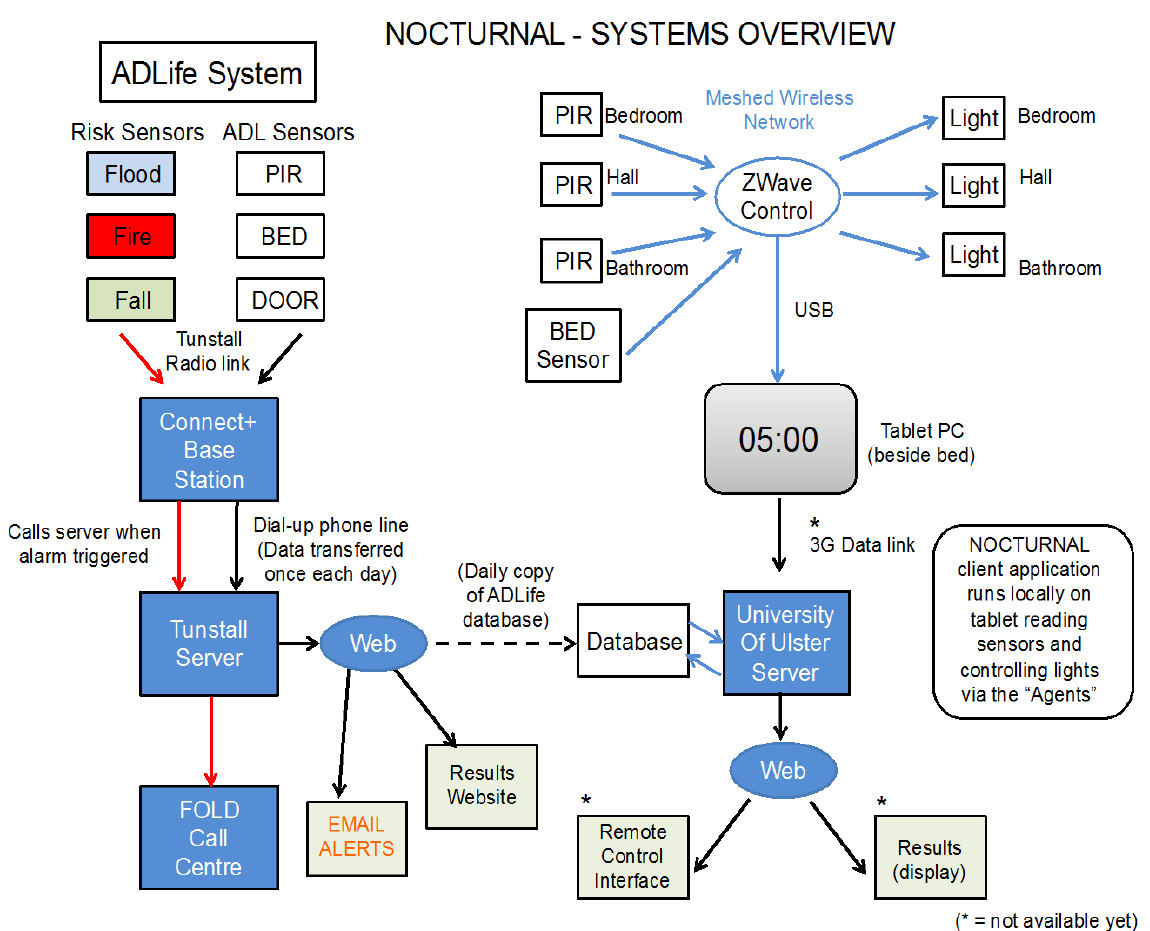
Figure 2. Overview of nocturnal